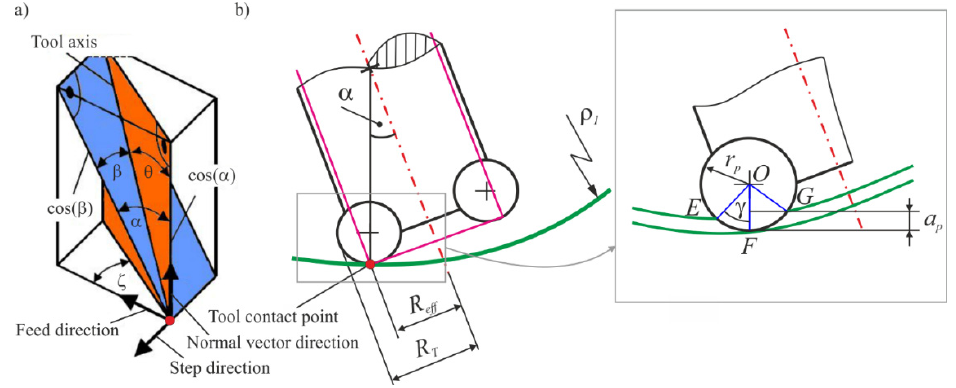
Figure 3. Analytical diagrams of tool orientation and tool contact position. ( a ) Tool orientation, ( b ) tool contact position.